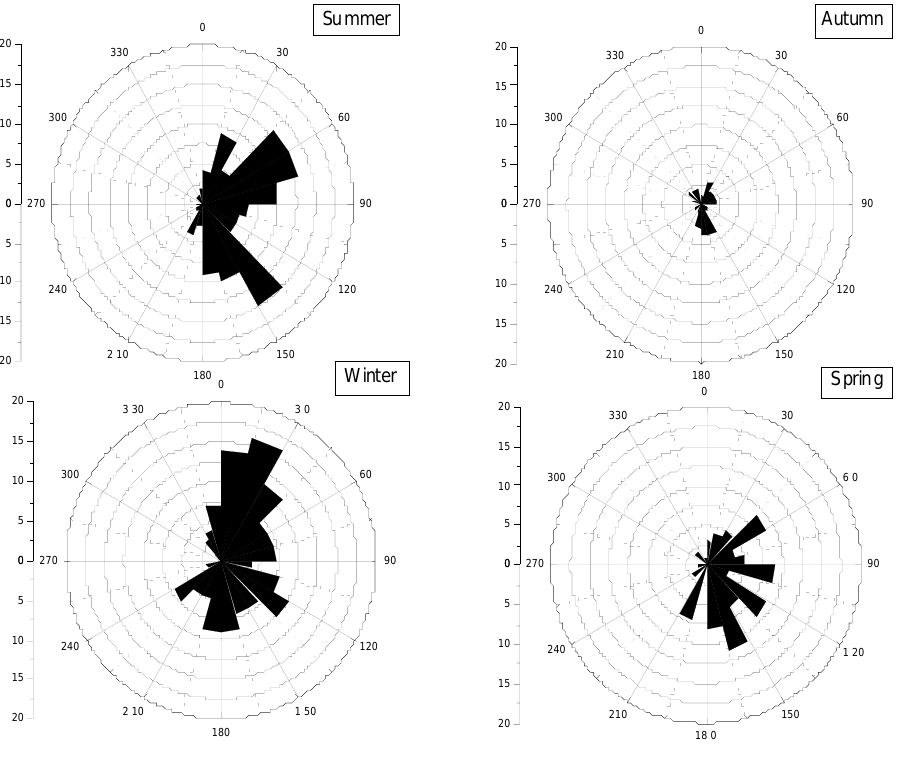
Fig. 8. Polar histograms of the propagation direction for bands for each season. Fig. 8 - Polar histograms of the propagation direction for bands for each season. Table 1. Band and ripple characteristics from airglow image data a